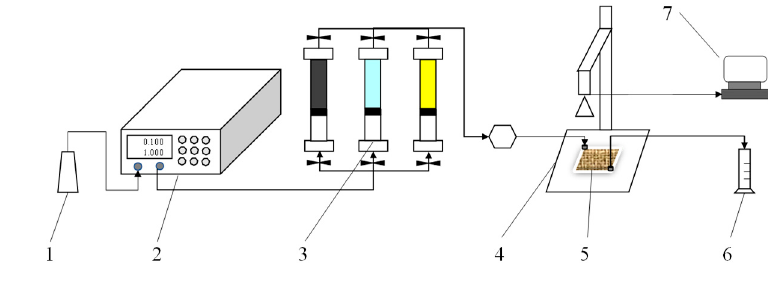
Figure 3. Schematic of microscopic visualization oil displacement experimental apparatus.